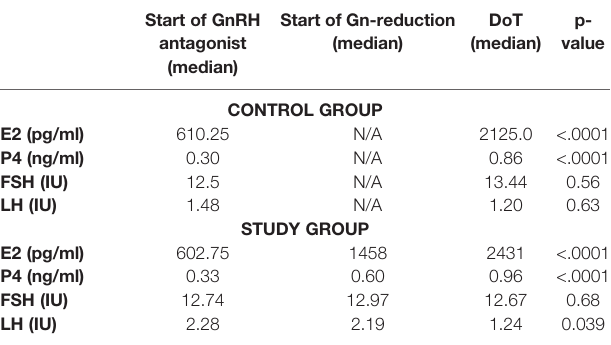
TABLE 3 | Evolution of the hormonal parameters of CG and SG for the timepoints: start of GnRH antagonist, start of Gn-reduction and day of